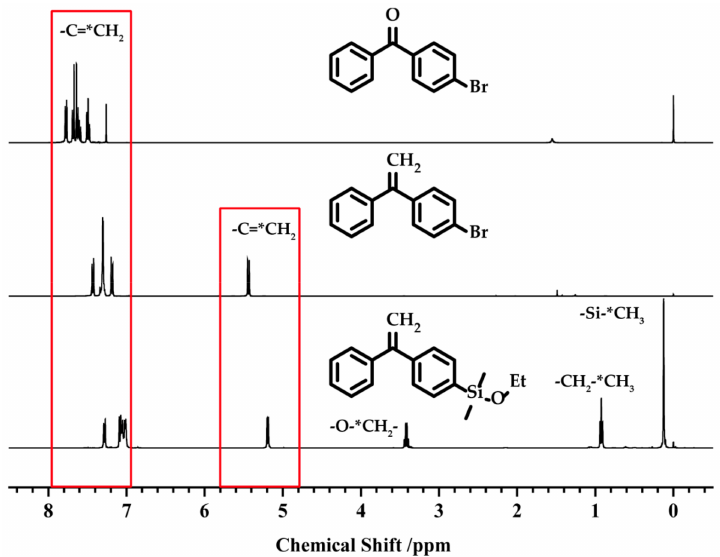
Figure 2. 1 H NMR spectra of ( 1 – 3 ). ( 1 ) 4-bromobenzophenone; ( 2 ) 1-(4-bromophenyl)-1-phenylethylene (DPE-Br); ( 3 ) 1-(ethoxydimethylsilyphenyl)-1-phenylethylene (DPE-SiOEt).